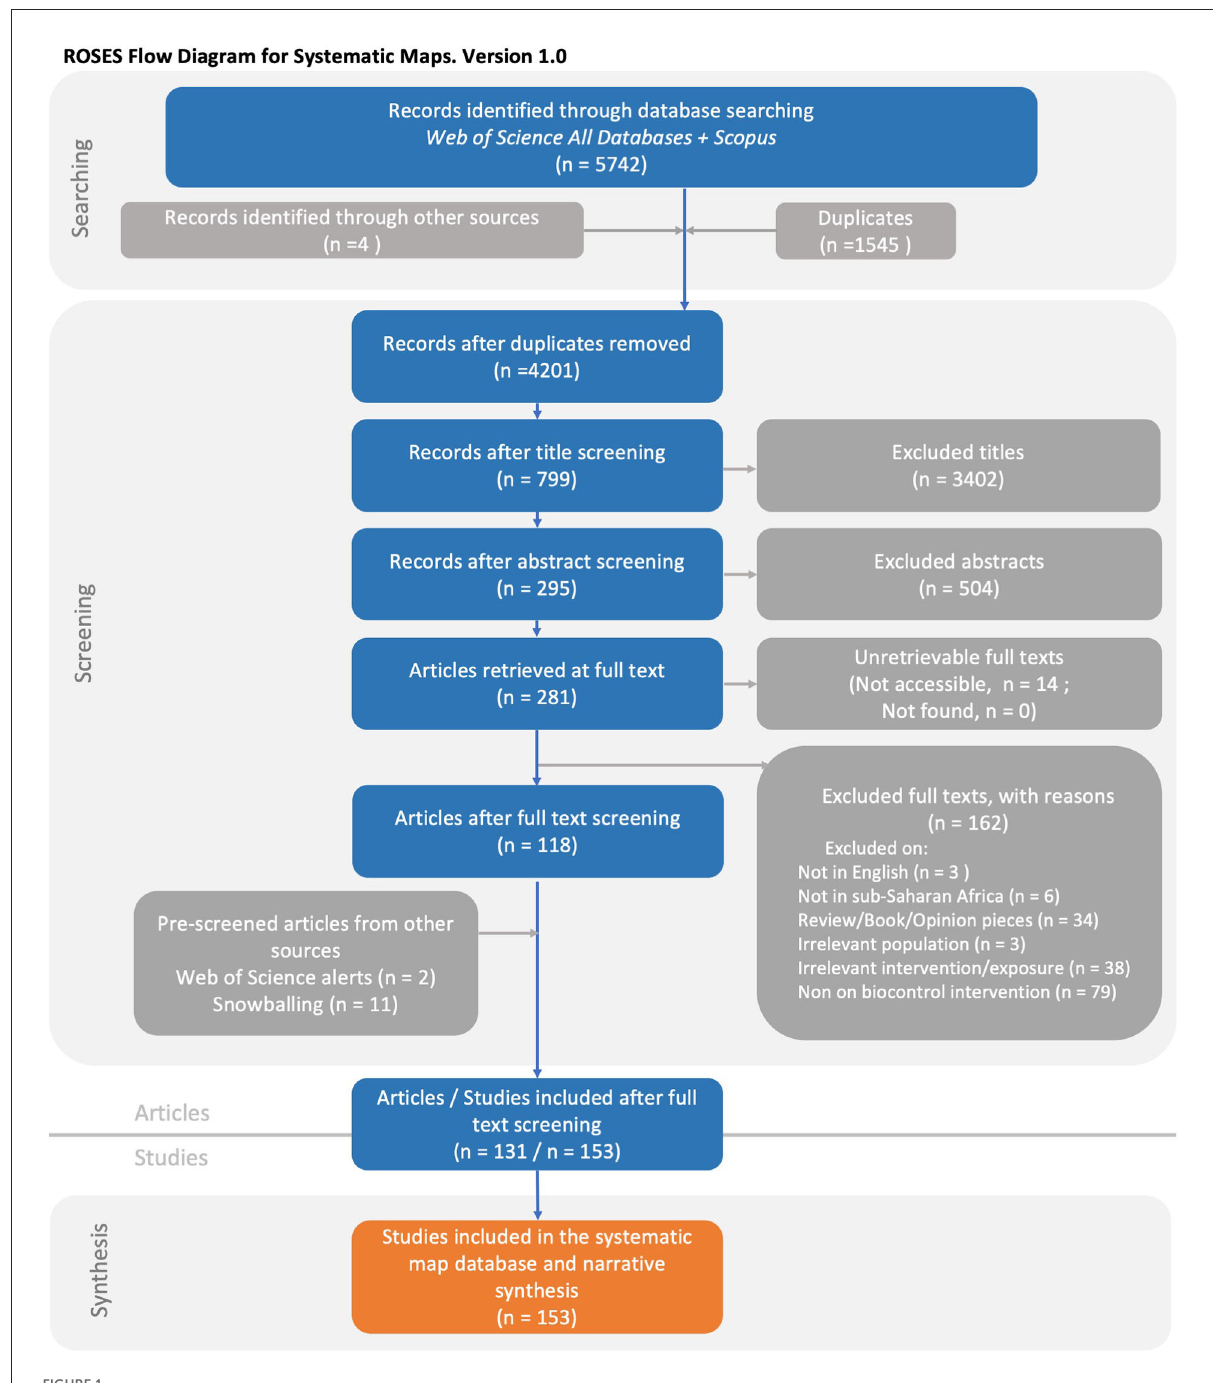
FIGURE1 ROSES flow diagram of the literature included and excluded at each step of the systematic map process.